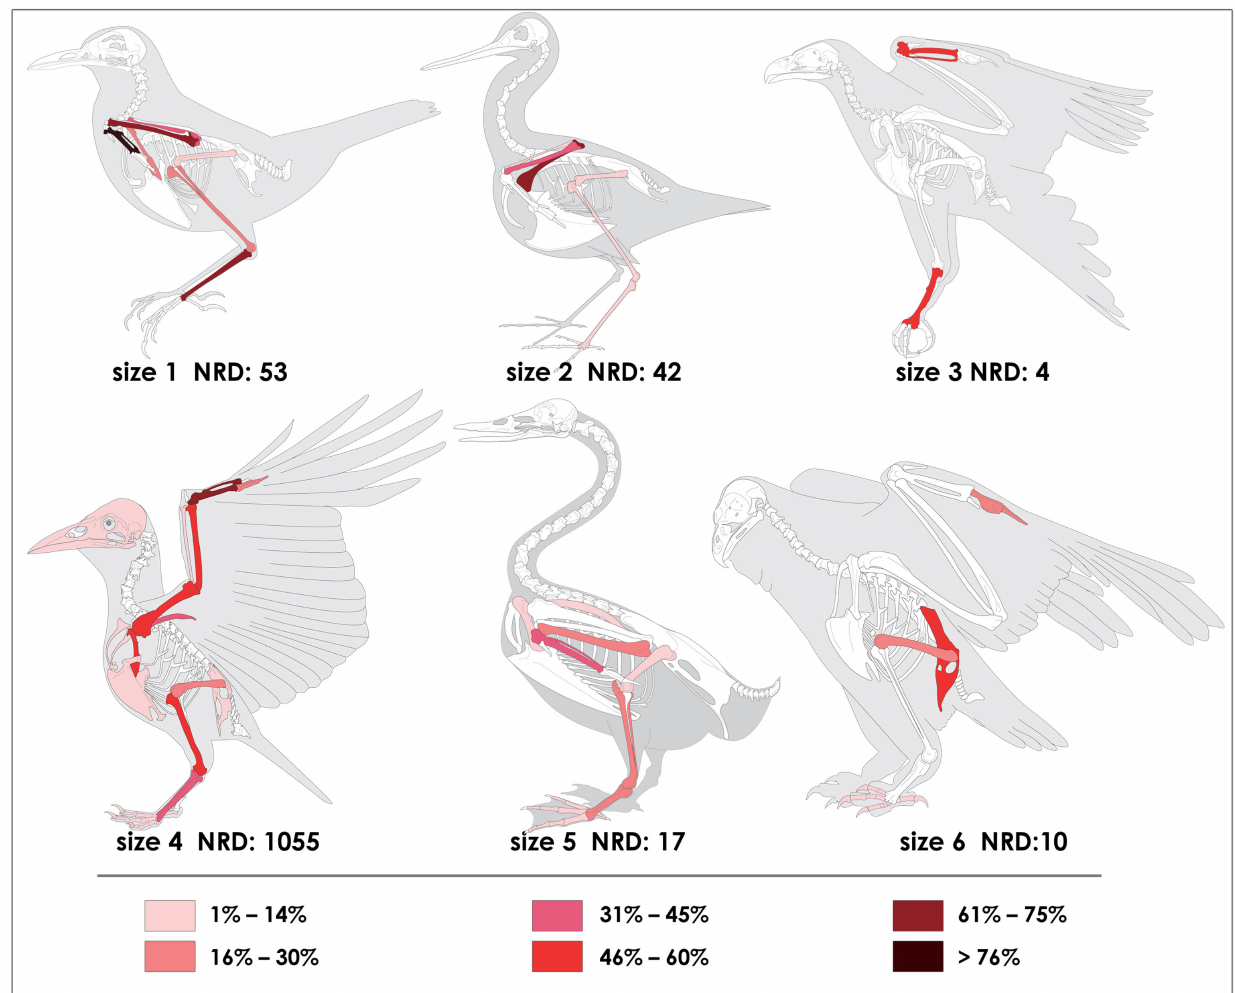
Figure 2. Percentage of relative abundance of bird remains at Grotte Vaufrey layer VIII classified by size. NRD: number of remains determined. See Materials and Methods for “size”